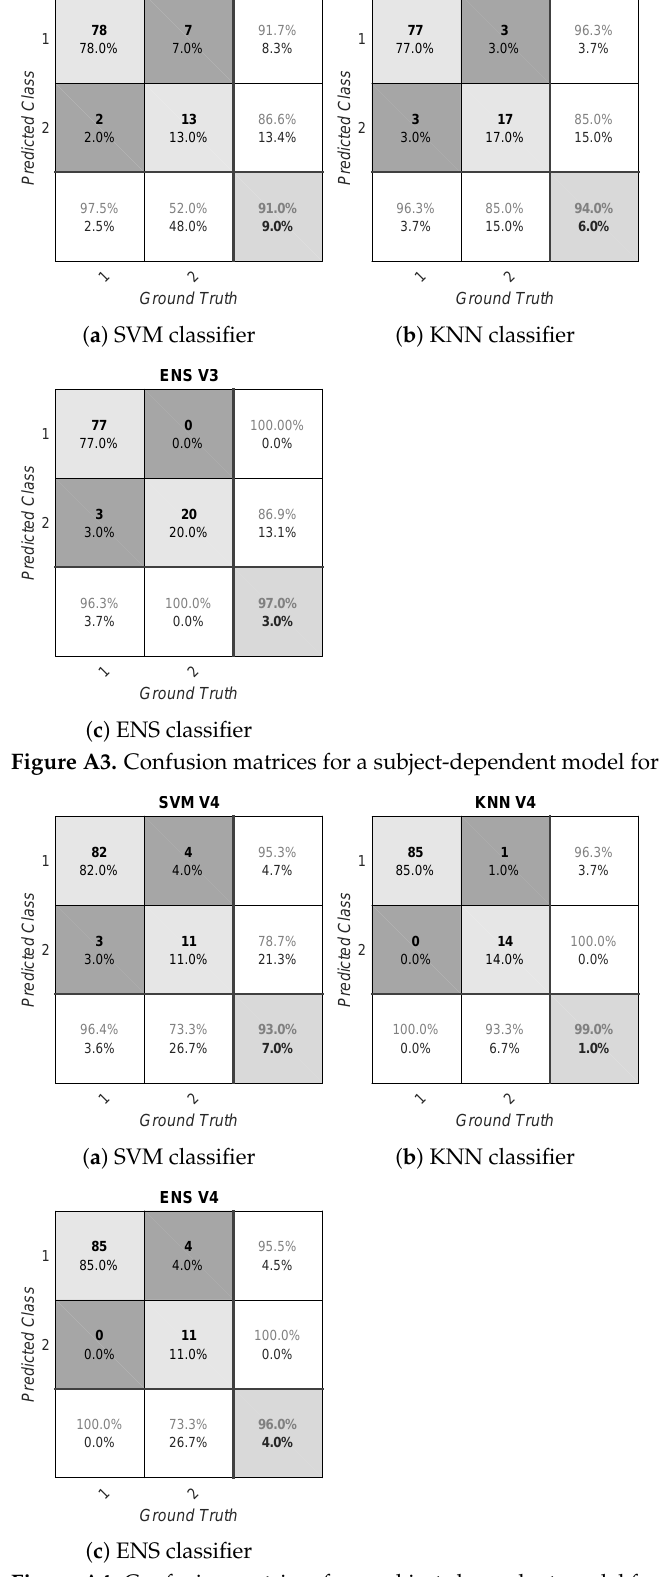
Figure A4. Confusion matrices for a subject-dependent model for